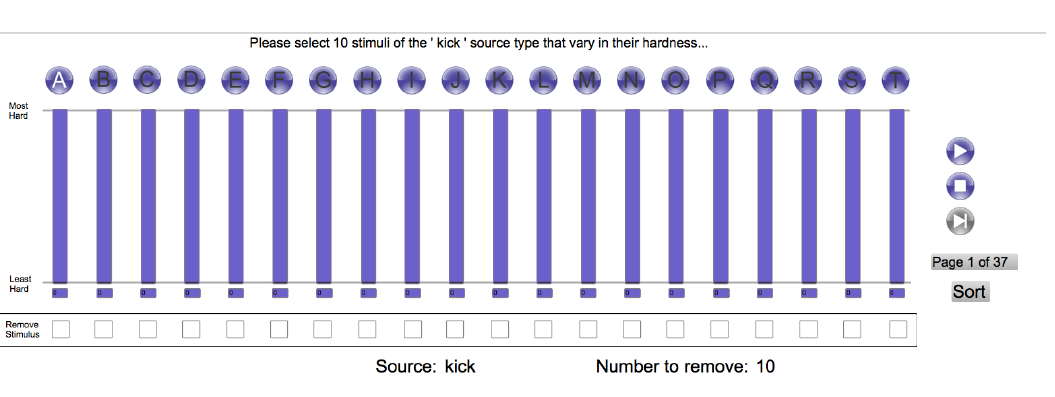
Figure 1. The interface used for selecting